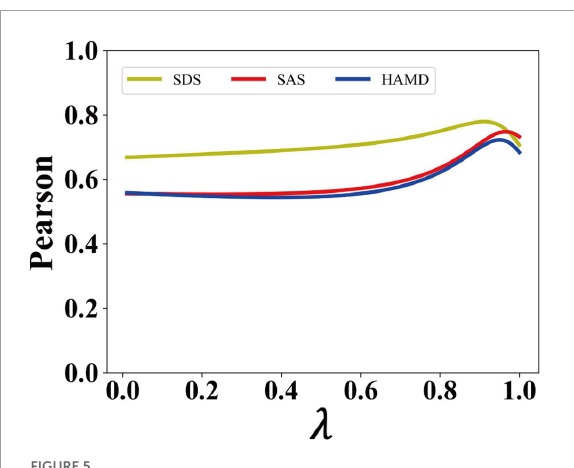
FIGURE5 The Pearson similarity of the proposed